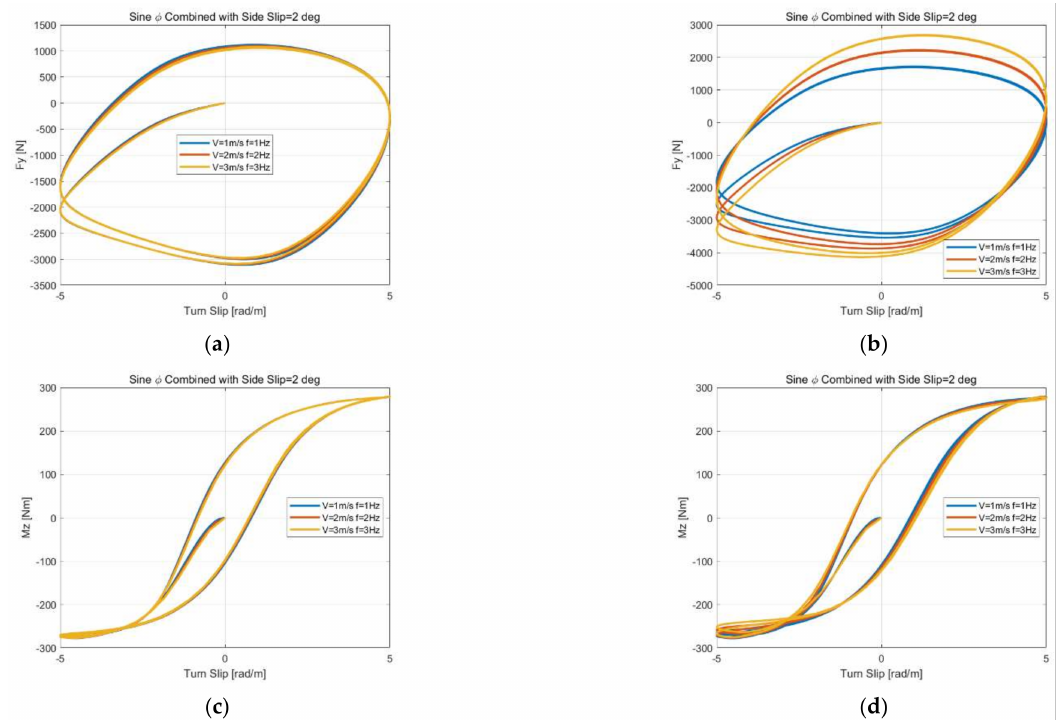
Figure 17. Response of lateral force and aligning moment under sine turn combined with a constant side slip. ( a ) Response of lateral force using the proposed method. ( b ) Response of lateral force using the reference method. ( c ) Response of aligning moment using the proposed method. ( d ) Response of aligning moment using the reference